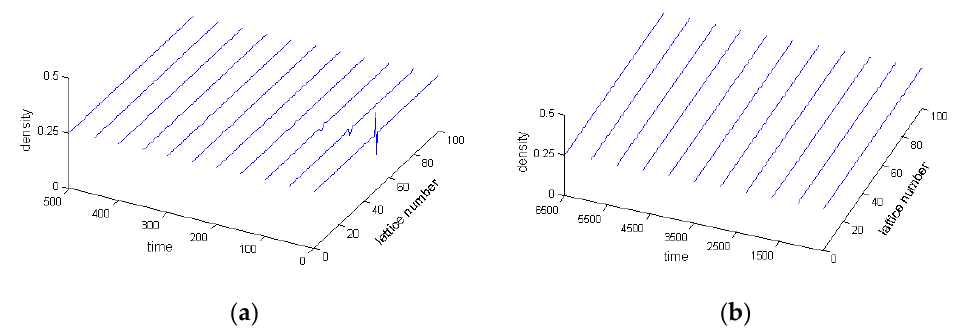
Figure 5. Traffic wave-developing process of the new model when =0.06  and